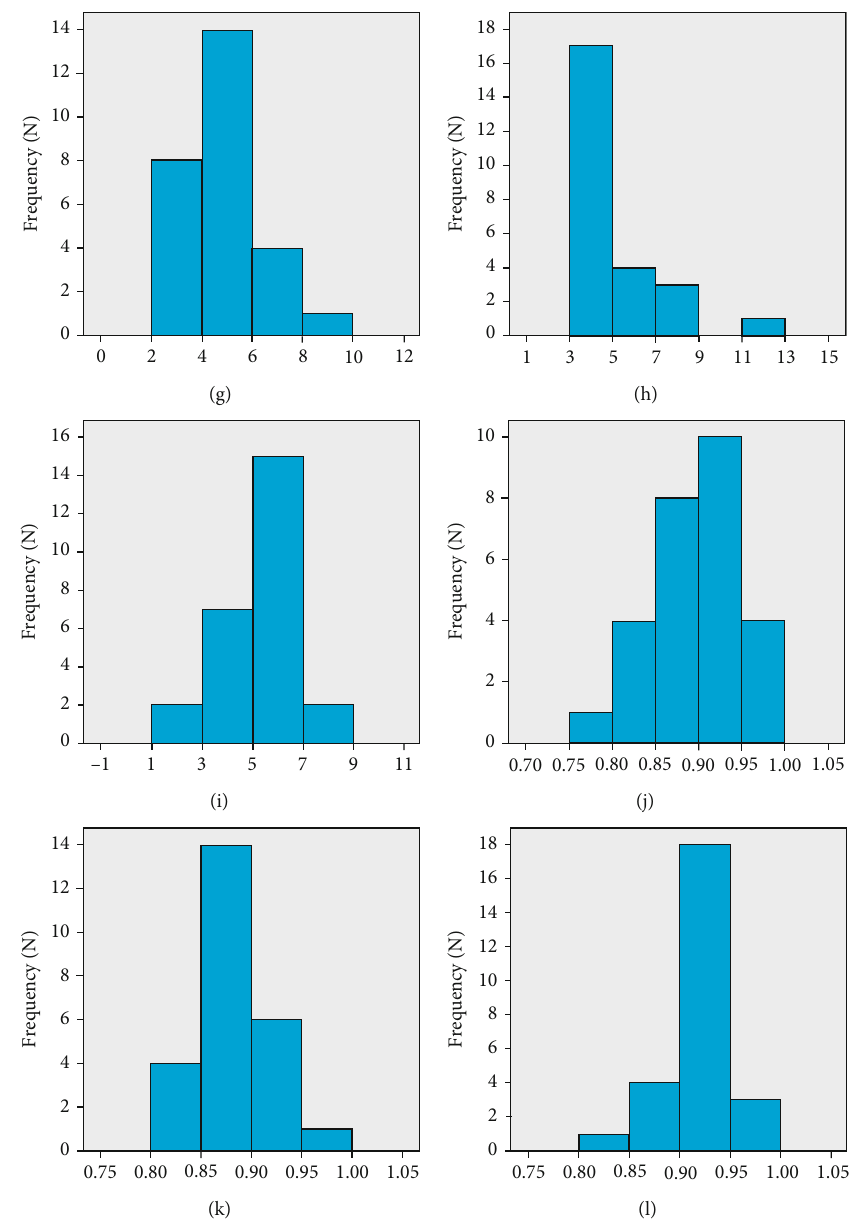
Figure 4: Histogram of temperature salinity and density at uniform temperature freezing